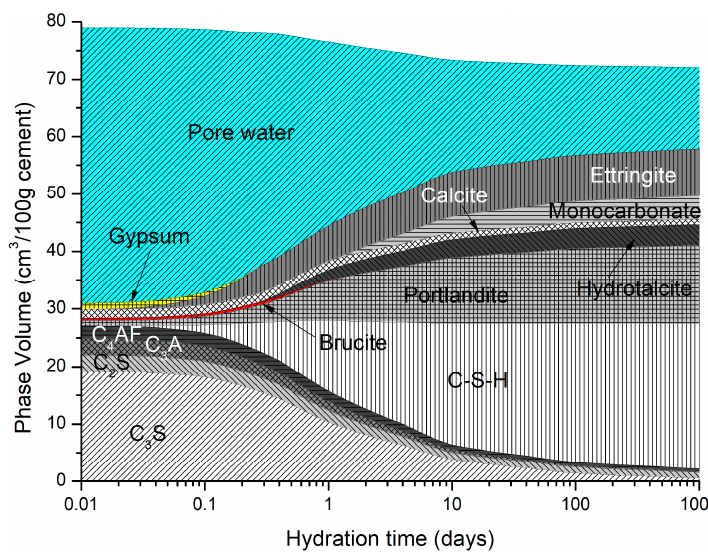
Figure 2. OPC cement predicted hydrate phases (curing temperature = 20